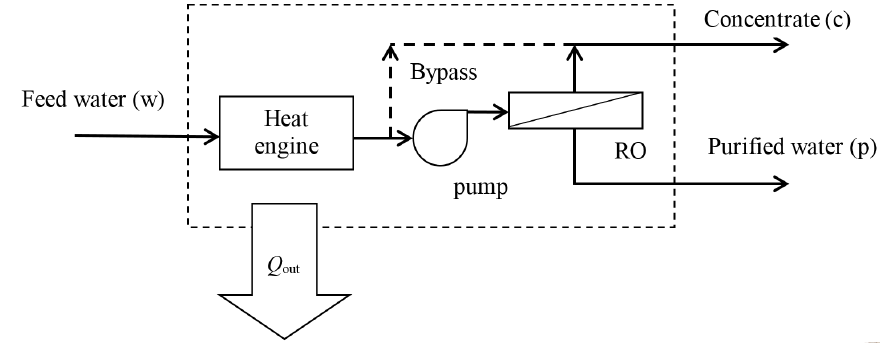
Figure 3. Self-powered desalination system comprising a heat engine coupled to a RO system: ( a ) without energy recovery device with optional bypass of feed water around the RO stage to allow it to work at optimum recovery r = 0.5 for cases where work output from the heat engine is limiting; ( b ) with energy recovery device (ERD) in which case no such bypass is